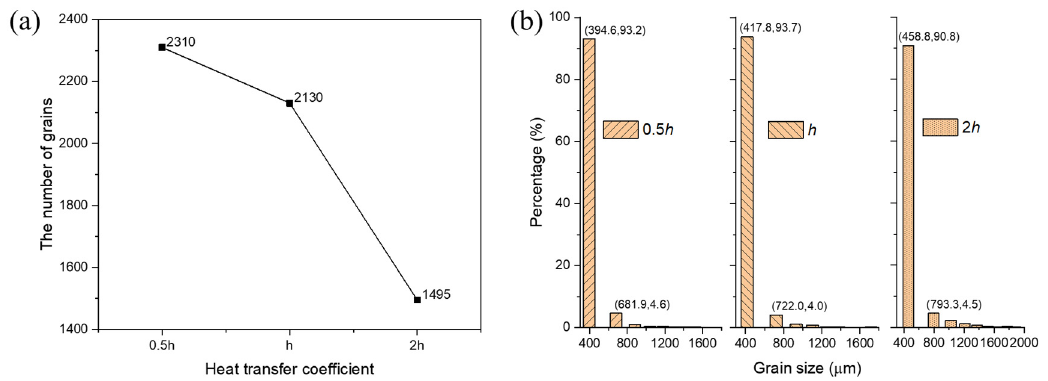
Figure 17. The total grain number and the grain size distribution of the whole cross ‐ section of the billet with different heat transfer coefficients, where ( a ) is the variations of total grains numbers, and ( b ) is the percentage of grains of different sizes.